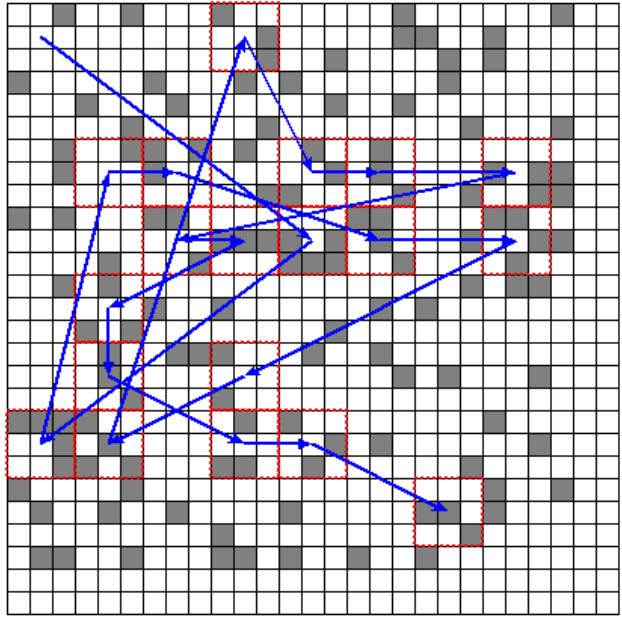
Figure 9. Path of a single